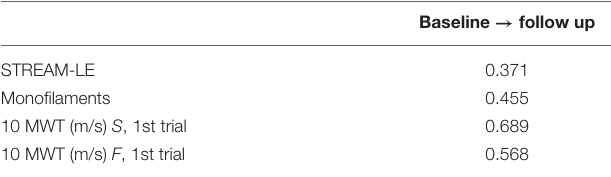
TABLE 2 | Mean (SD) of outcomes measures over time. TABLE 3 | Effect size of treatment between Baseline and